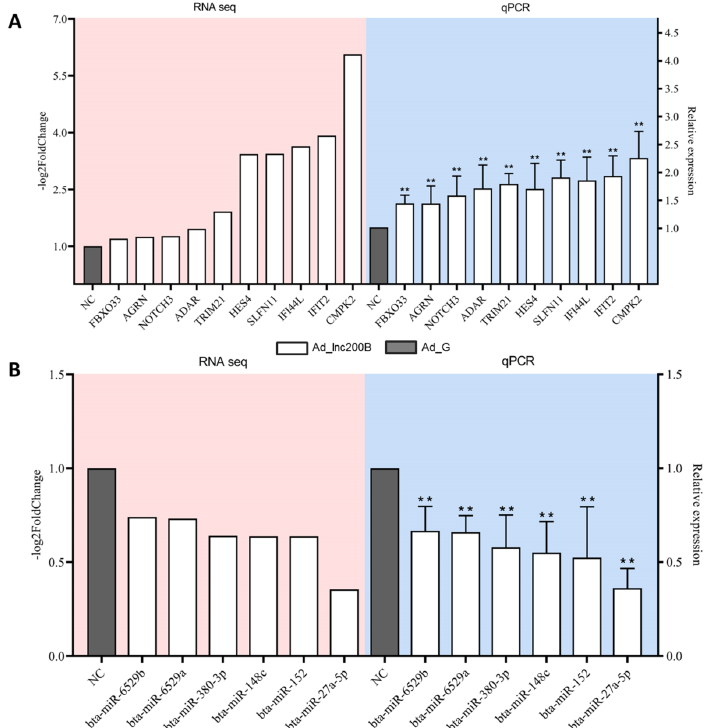
Figure 4. The validation of the mRNA and miRNA expression after lncFAM200B overexpression. ( A ) The mRNA expression levels of DEGs. ( B ) The miRNA expression levels of DEMs. Results are presented as mean ± standard deviation (SD) from three independent experiments. ** p < 0.01.